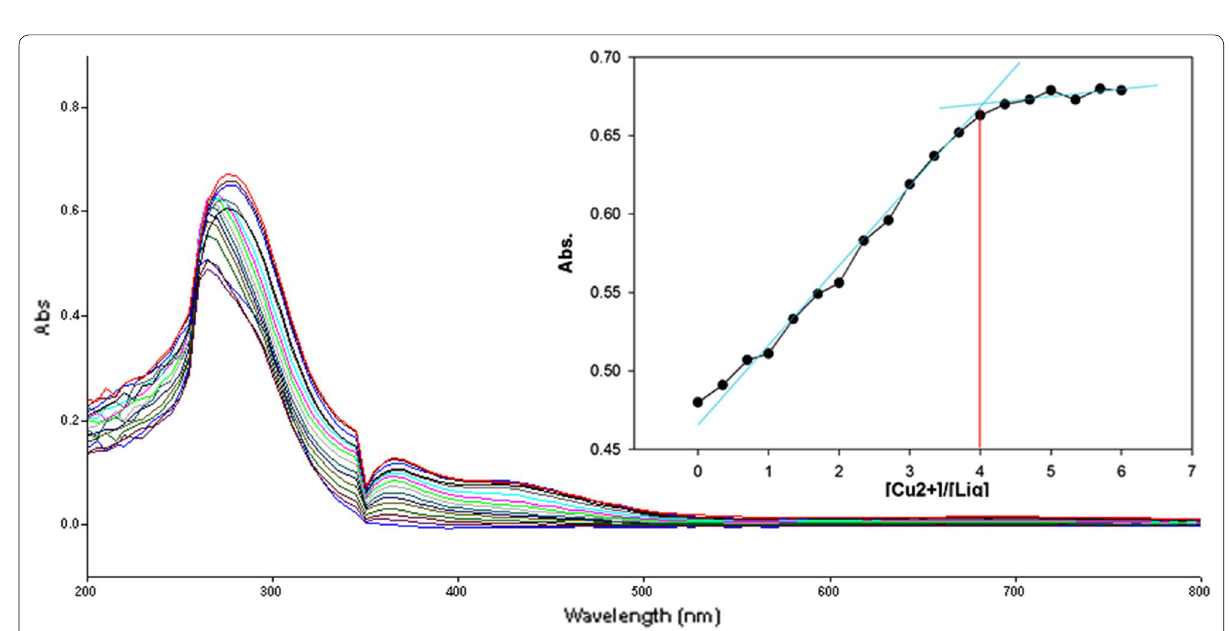
Fig. 10 Titration of isomer 1A vs Cu 2 + ( Inset Binding behavior